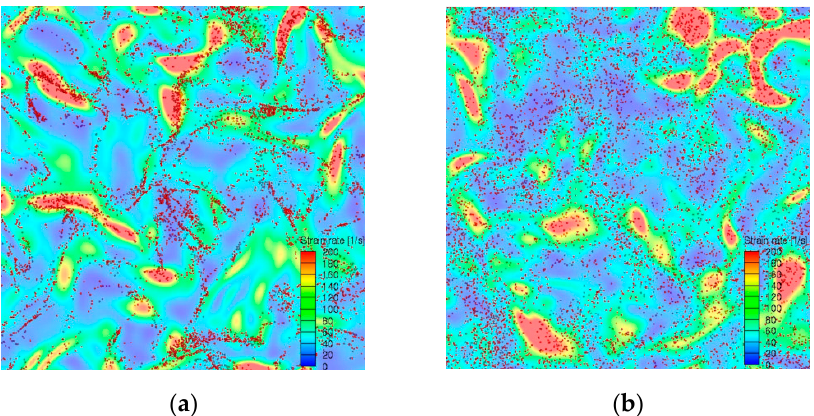
Figure 2. Snapshot of a two-dimensional (2D) slice of the fluid turbulent field laden with particles, where background is coloured by fluid strain rate. Particle segregation illustration for particles with intermediate ( St K = 1) and large ( St K = 10) inertia, ( a ) and ( b ), respectively. Particle volume fraction α p = 0.1%. Edge lengths l and thickness s of the image sections: l / η = 128 and s / η = 2, respectively. The diameter of the spheres is enlarged by a factor or 3 for the sake of better visibility.